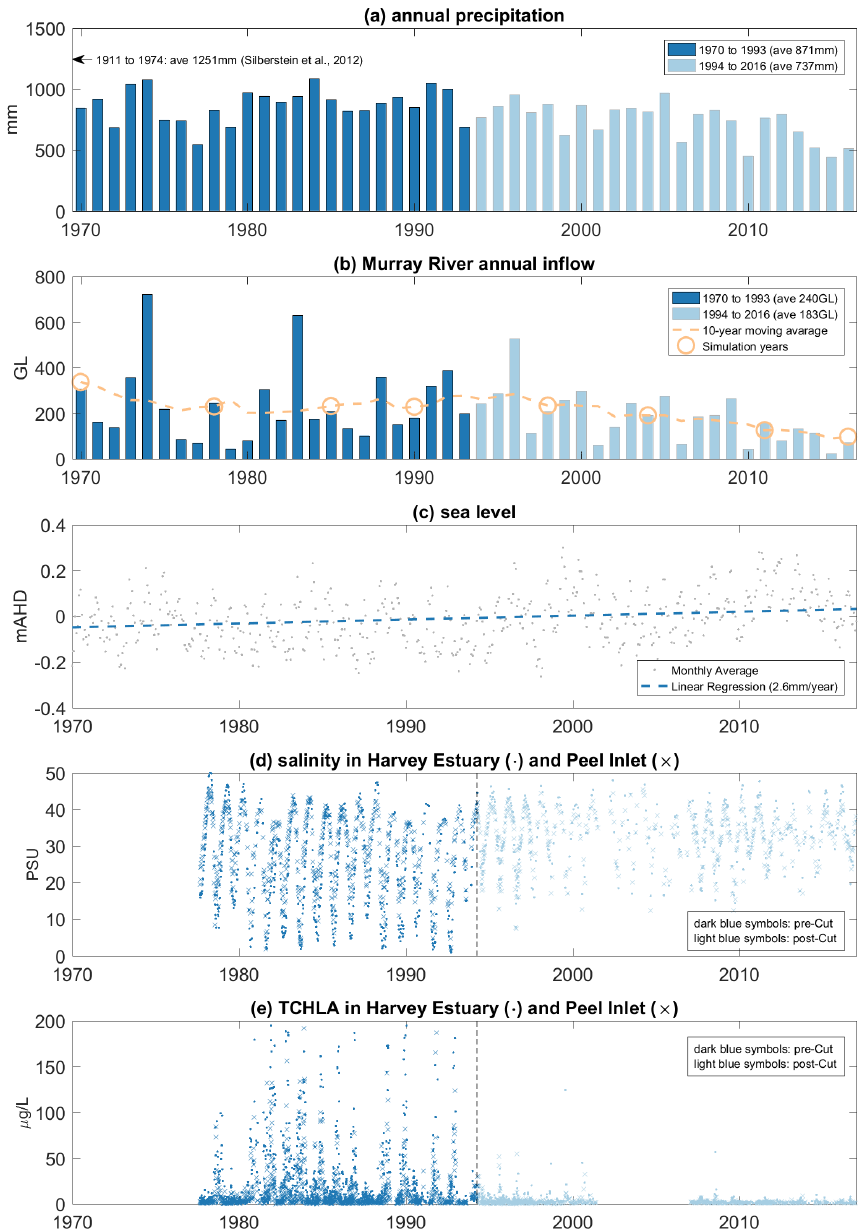
Figure 2. Historical record of (a) annual precipitation rate, (b) Murray River annual inflow rate, (c) monthly-average sea level at Fremantle gauge station, (d) salinity at Harvey Estuary and Peel Inlet, and (e) total chlorophyll a (TCHLA) in Harvey Estuary and Peel Inlet since 1970 to